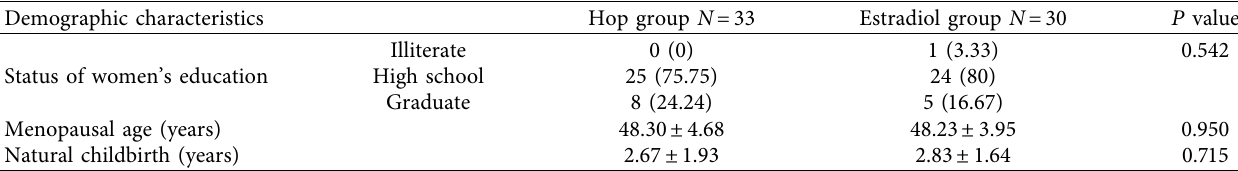
Table 1: Demographic characteristics of the participants.